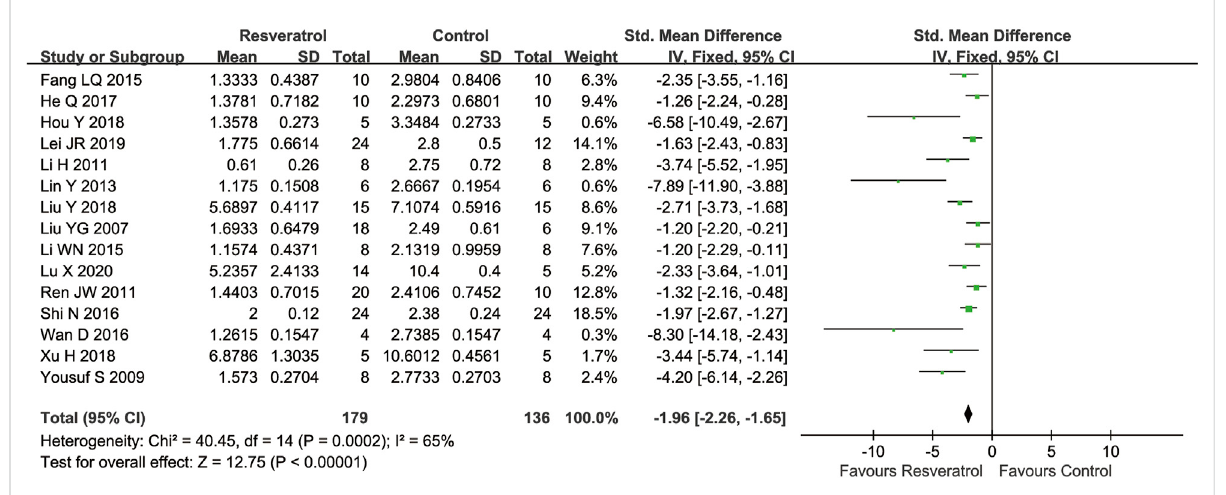
FIGURE 4 Meta-analysis of resveratrol for neurological de fi cit scores in rats after cerebral I/R